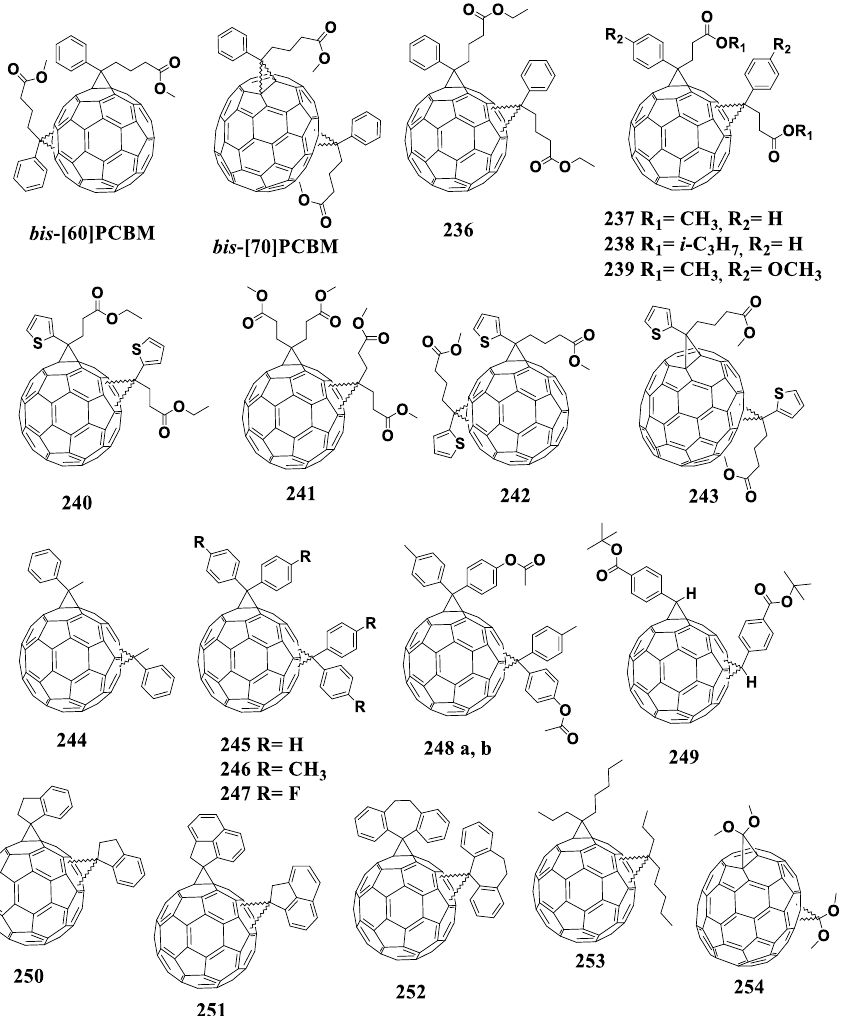
Figure 20. Molecular structures of the bis(cyclopropane) adducts of fullerenes with reduced electron affinity.